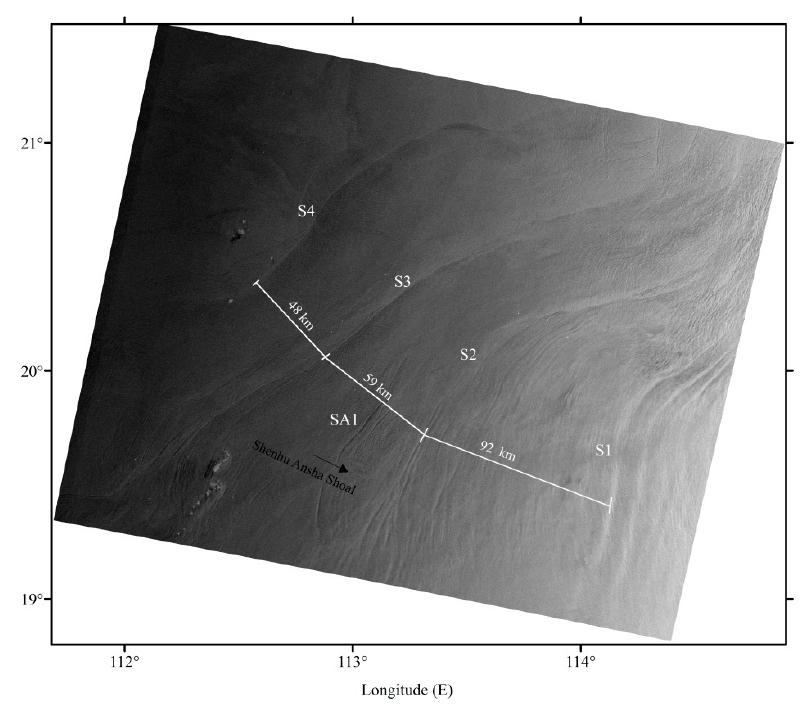
Figure 2. An Envisat ASAR image acquired at 02:30:04 UTC on 8 June